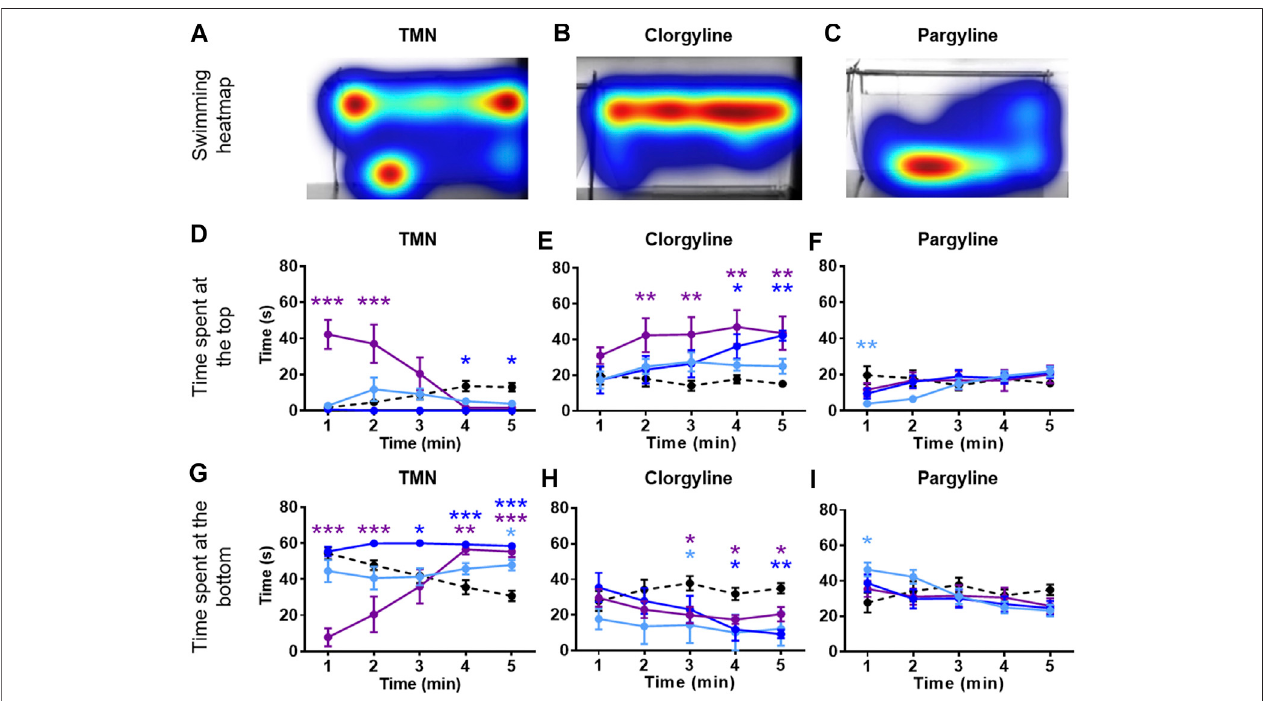
FIGURE 3 | NTT results for TMN, clorgyline, and pargyline. Representative heatmaps for (A) TMN (30 mg/L) (B) clorgyline (100 mg/L), and (C) pargyline (10 mg/L) duringtheNTTforonezebra fi shpercompoundareshown.Theheatmapsshowtheminimum(darkblue)tomaximum(darkred)amountoftimea fi shspentineachpixel. Time spent at the top and the bottom of the tank are quanti fi ed for (D and G) TMN (3, 10, and 30 mg/L), (E and H) clorgyline (10, 30, and 100 mg/L), and (F and I) pargyline (10, 30, and 100 mg/L). All compounds show anxiolytic-like effects at at least one of the concentrations and time point. Black dashed line (cid:1) vehicle control;lightblue (cid:1) lowestconcentration;blue (cid:1) middleconcentration;purple (cid:1) highestconcentration.Thesamplesizewas12exceptforcontrolgroupforTMN( n (cid:1) 11), 3 mg/LTMN( n (cid:1) 9),10 mg/Land30 mg/LTMN( n (cid:1) 7),30 mg/LClorgyline( n (cid:1) 8),and100 mg/LClorgyline(n (cid:1) 6).Dataareexpressedasmean ± SEM.* p < 0.05;** p < 0.01; *** p < 0.001; Abbreviations: NTT (cid:1) novel tank test; TMN (cid:1)